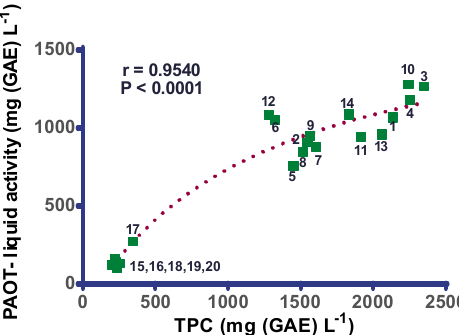
Figure 3. Correlation between TPC (total polyphenols content) and PAOT-Liquid ® activity in red ( n = 14), rosé ( n = 3) and white wines ( n = 3) bought in a Belgian commercial market.